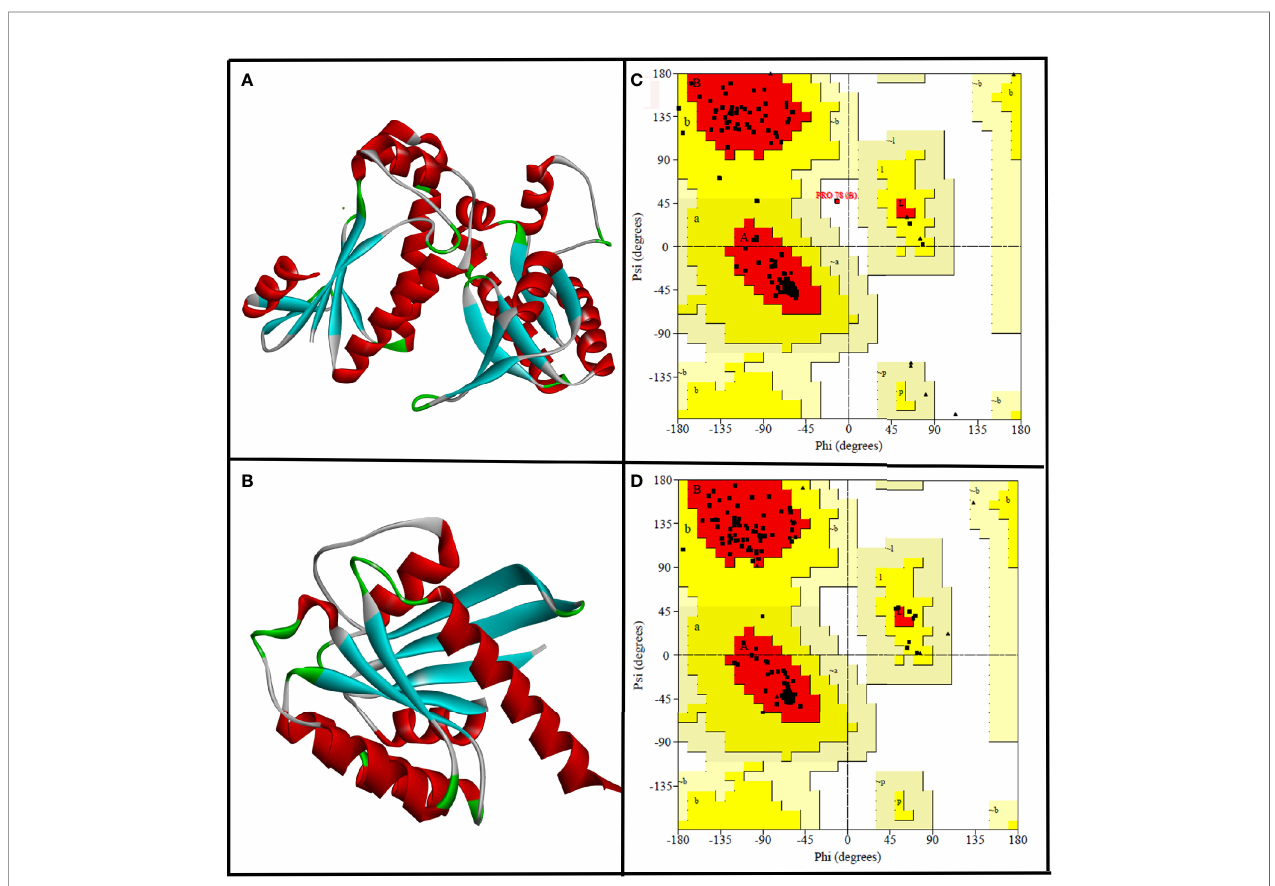
FIGURE 1 | The three-dimensional structure of CYCc (A) and RAS1 (B) built using SWISS-MODEL. Ramachandran plot generated portraying the stereochemical qualities of the modeled CYCc (C) and RAS1 (D)